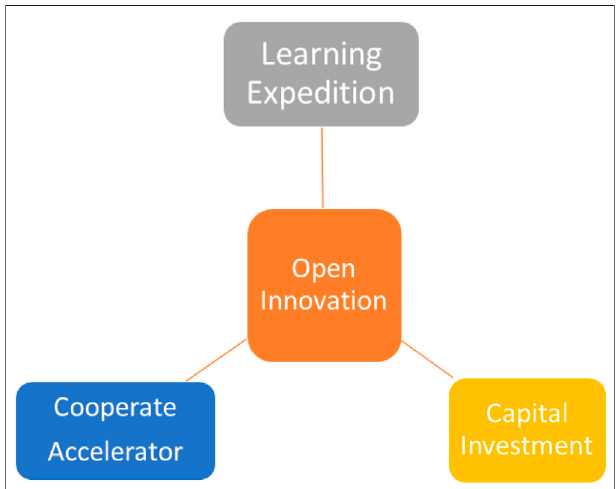
FIGURE 7 | The methodological way to deal with construct